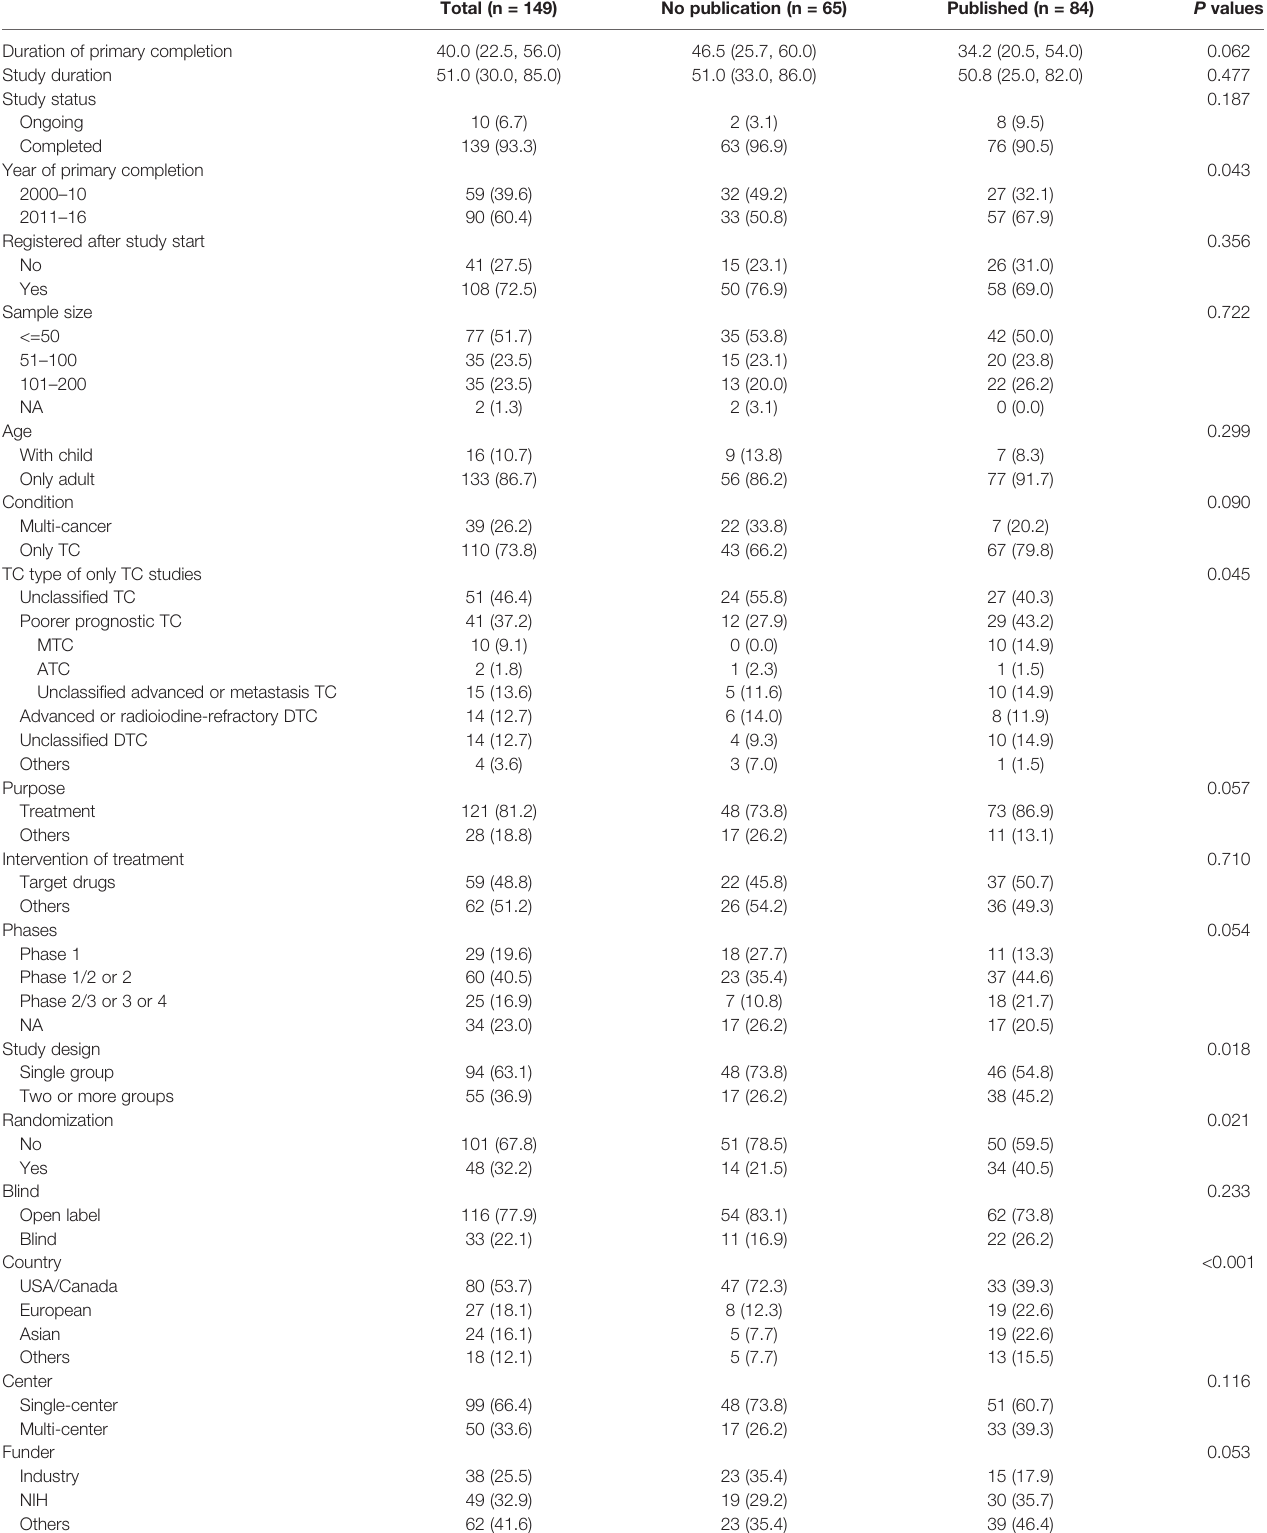
TABLE 2 | Characteristics of interventional studies which had primary